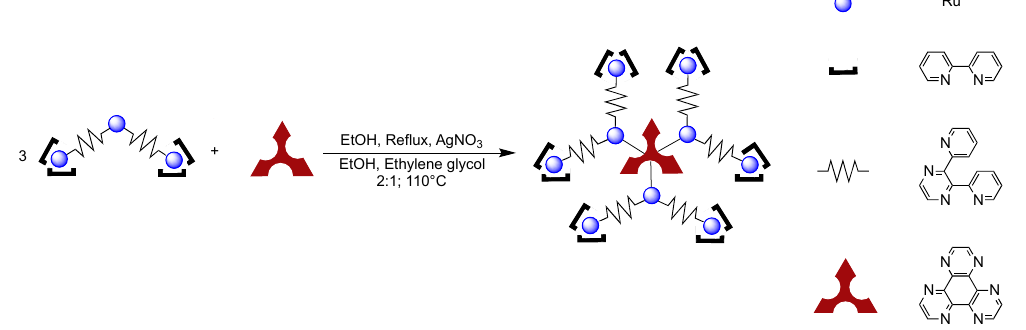
Figure 42. Pathway for the synthesis of the first ligand-cored nonanuclear dendrimer